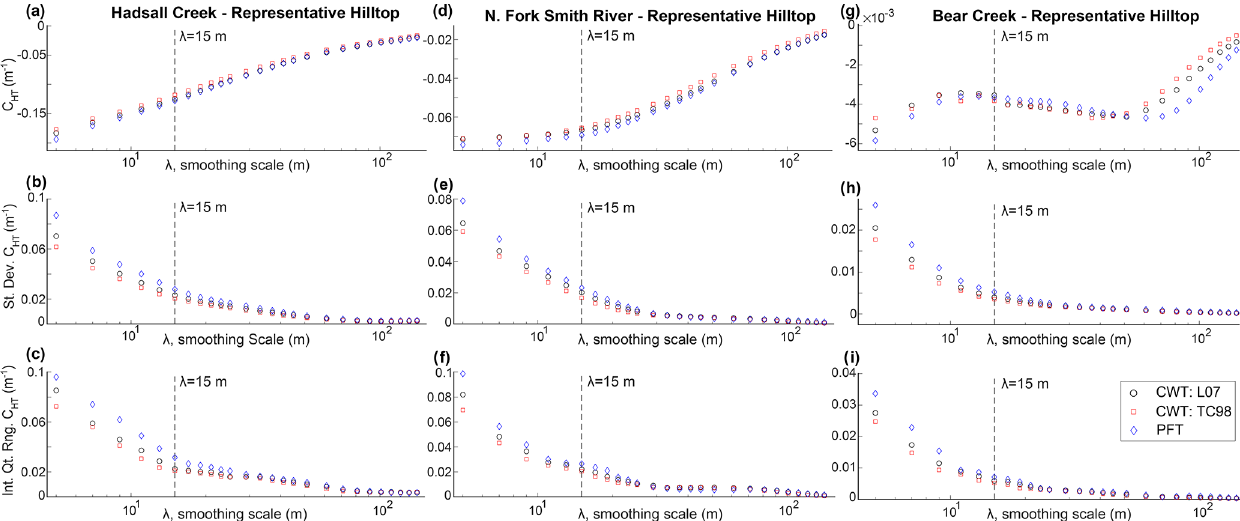
Figure 3. Curvature extracted from representative hilltop at Hadsall Creek, NFSR, and Bear Creek for a range of λ . Upper row (a, d, g) is C HT measurements, second row (b, e, h) is the standard deviation of C HT , and the bottom row (c, f, j) is the interquartile range of C HT . Note that the scaling break that identifies where tree throw pits are filtered out depends on the size of the considered hillslope and consistency of pit–mound topographic in a landscape. Here, though, a break exists at λ ≈ 15m for Hadsall Creek (especially apparent in standard deviation and interquartile range) and the NFSR and Bear Creek at λ ≈ 11–20m (note that second break at ∼ 60m in Bear Creek corresponds to the introduction of concave valleys). These scaling breaks are generally consistent with those observed for the OCR by Roering et al. (2010) and are visible for CWT and PFT λ definitions. L07: Lashermes et al. (2007); TC98: Torrence and Compo (1998). Table 3. Recalculated CRN erosion rates. We used the CRONUS online calculator (Balco et al., 2008) to determine catchment-averaged erosion rates from 10 Be in stream sediment. The samples from Hadsall Creek and NFSR are recalculated from the 10 Be data presented by Penserini et al. (2017). Reported CRN error is from external uncertainty. Catchment Location Concentration Error Erosion rate Error